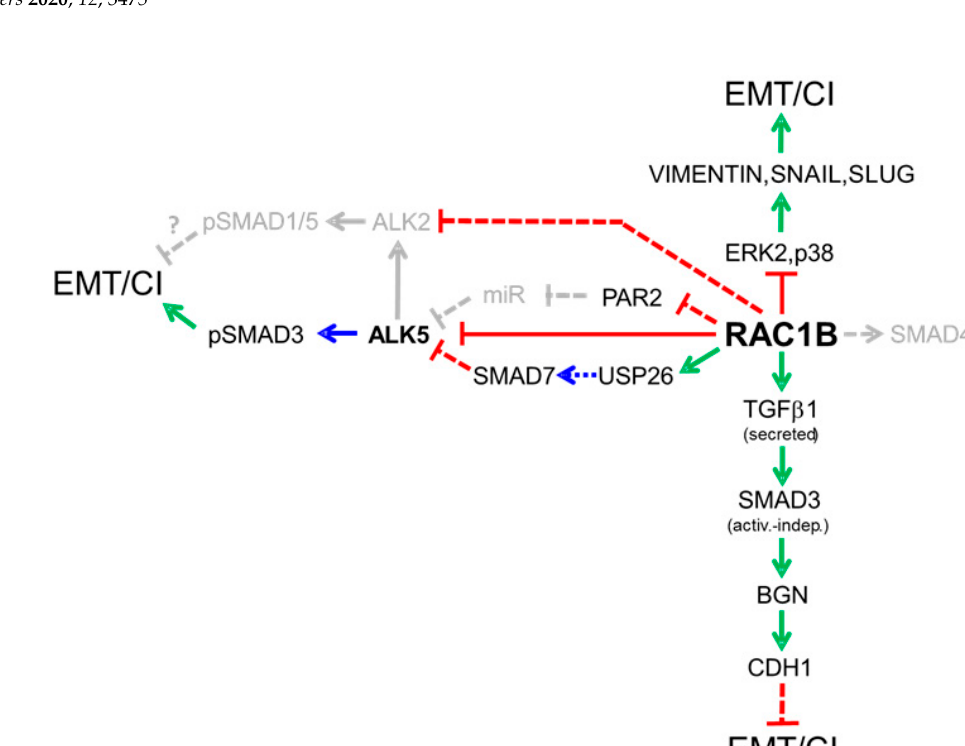
Figure 3. Diagram summarizing our previous findings on the regulatory interactions of RAC1B with TGF β signaling mediators and MAPKs that in a TGF β -dependent or independent manner inhibit epithelial–mesenchymal transition (EMT) or cell invasion (CI) in pancreatic epithelial cells. Green arrows denote stimulation of expression, blue arrows stimulatory post-translational modifications and red lines inhibition of expression. Stippled lines indicate the possible involvement of intermediary factors. Pathways in gray color are either hypothetical or have not yet been published.